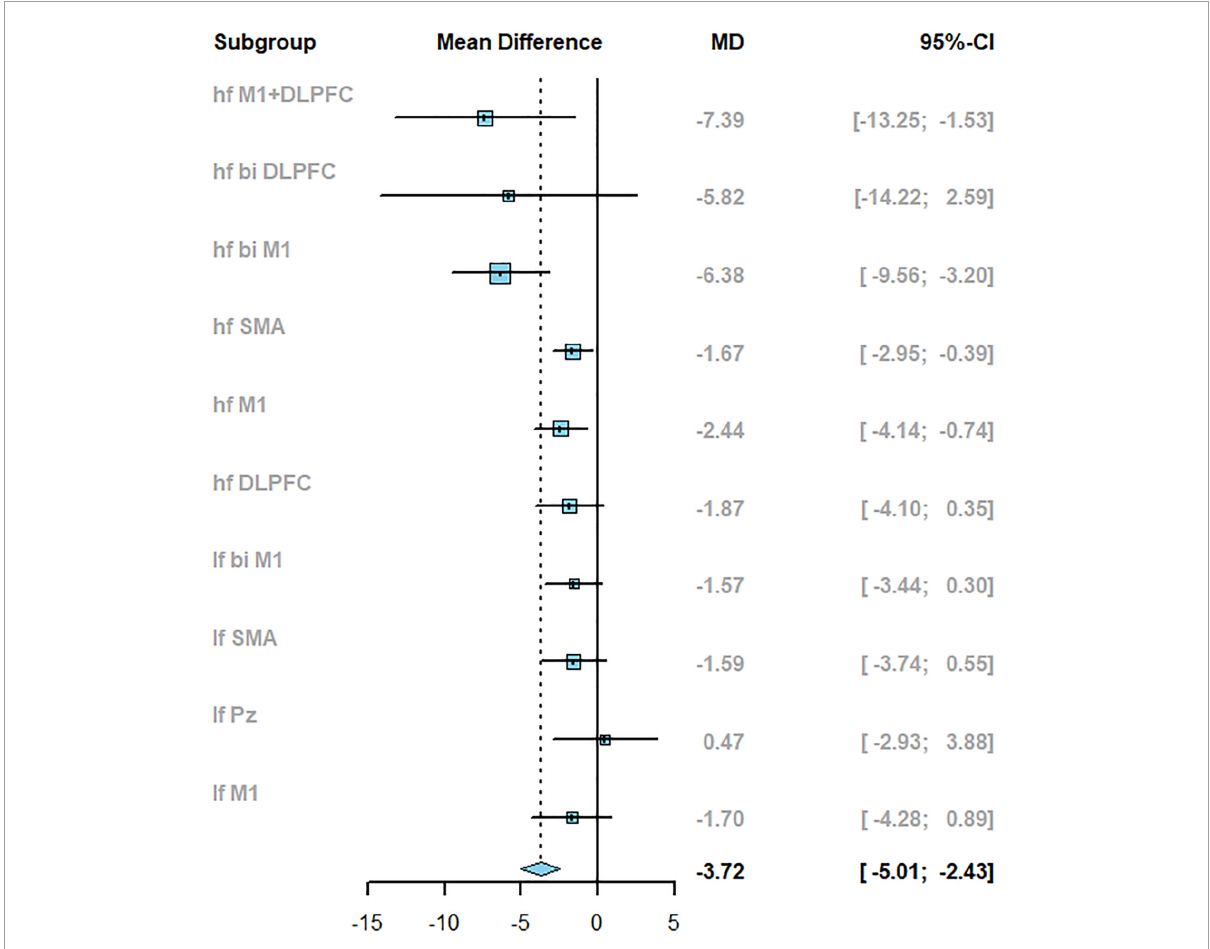
FIGURE4 The results of pair-wise meta-analysis reported with mean difference (MD) and 95%CI when compared to sham.